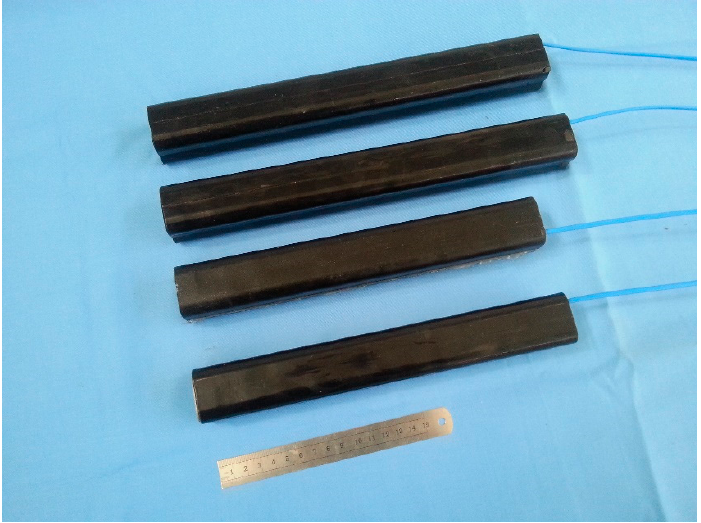
Figure 11. Prototypes of cascade-connected transducers.